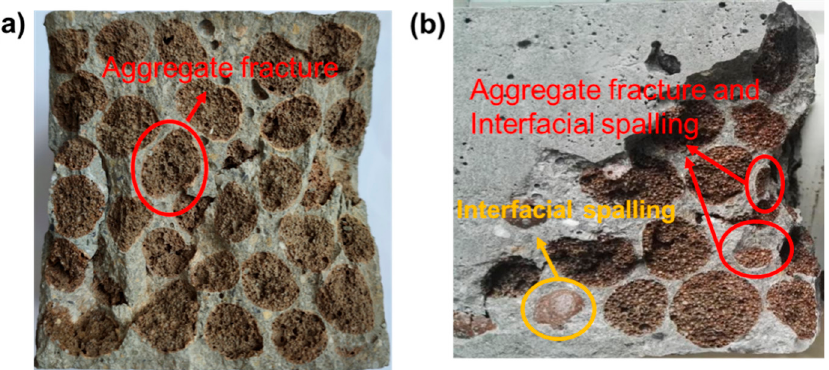
Figure 1. Failure morphology ( a ) Ordinary lightweight aggregate concrete and ( b ) Core–shell lightweight aggregate concrete.